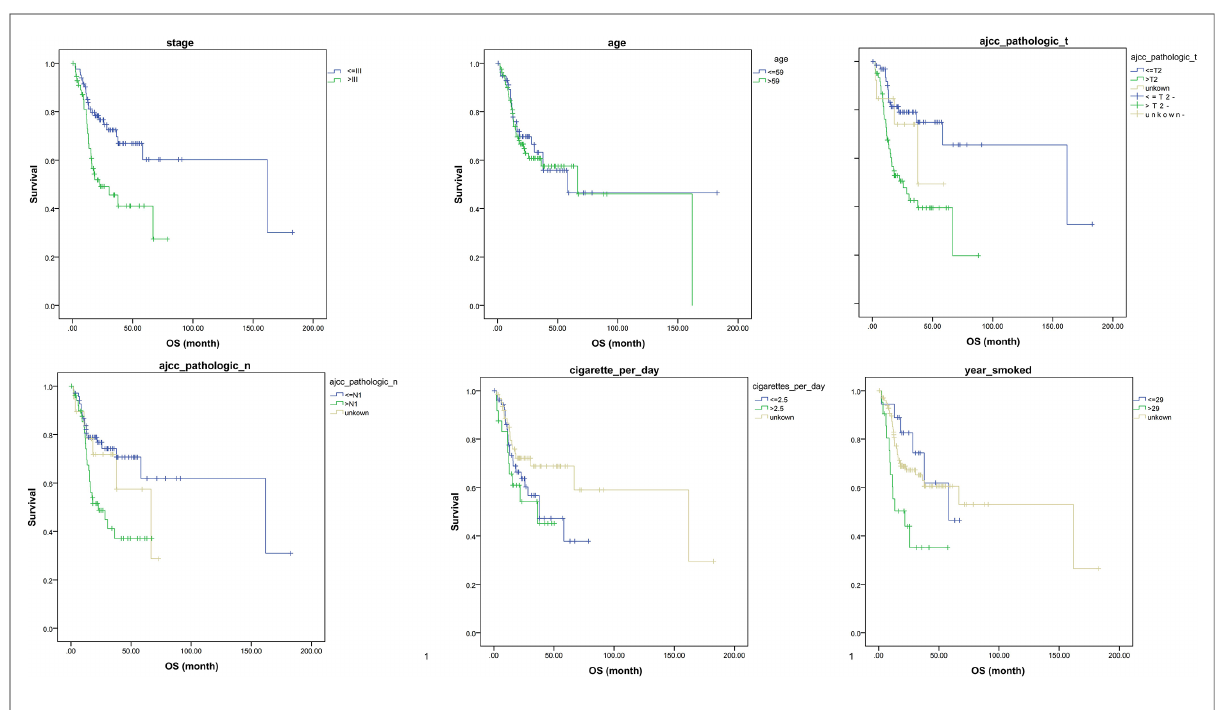
FIGURE 7 SPSS software used to analyze the individual clinical features and prognosis.